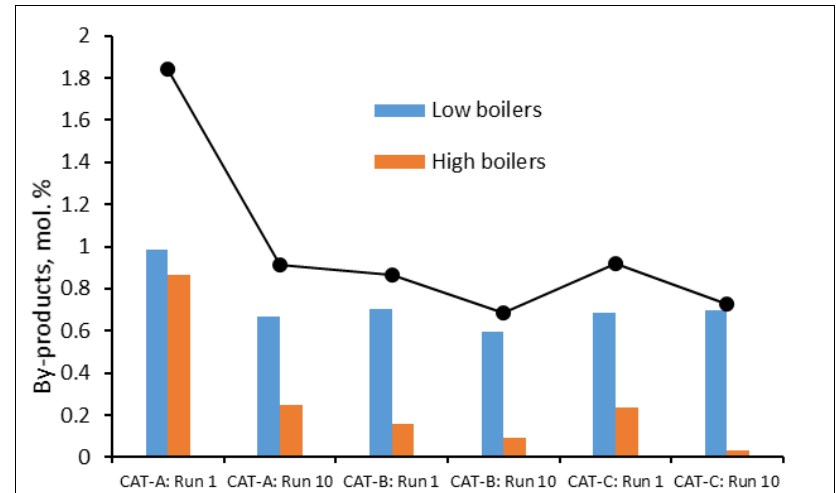
Figure 5. Quantity of by-products produced using CAT-A, CAT-B and CAT-C for dehydrogenation of H18-DBT. Reaction conditions: batch reactor, reaction time 100 min for each run, reaction temperature 300 °C, catalyst Pt/Al 2 O 3 , n Pt /n H18-DBT (99.7 doh) 0.05 mol %.